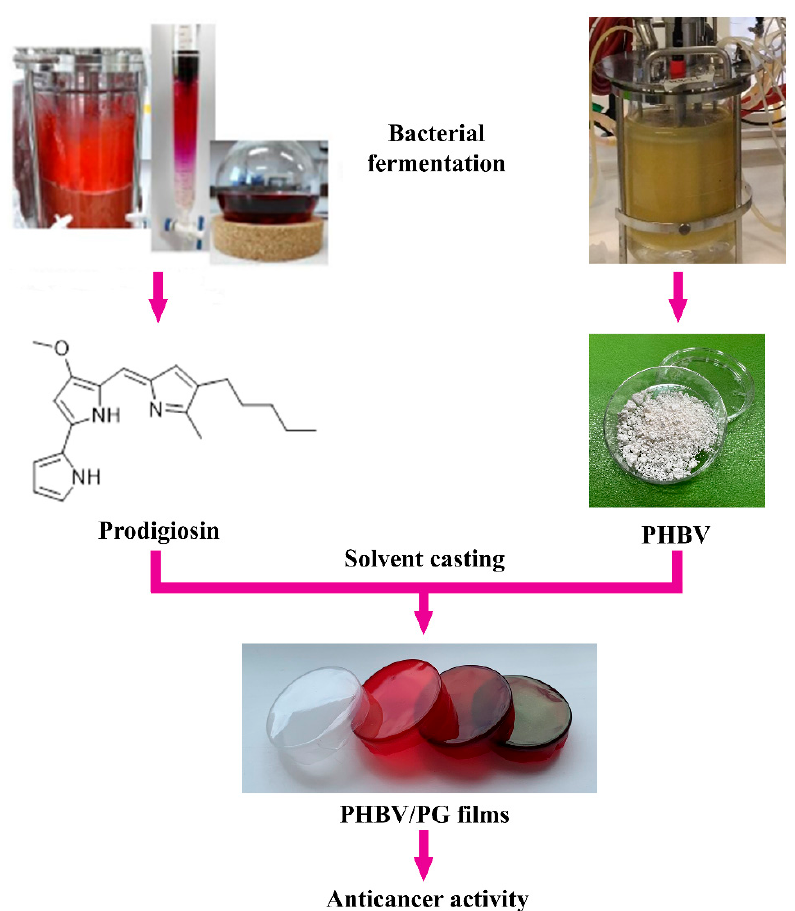
Figure 1. Study design and potential biomedical application of the PHBV films with incorporated prodigiosin (PG).